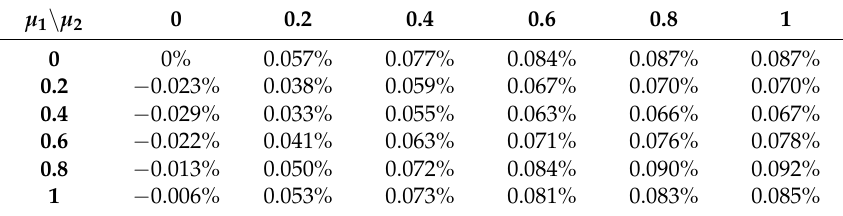
Table 6. Relative change of CVaR values for